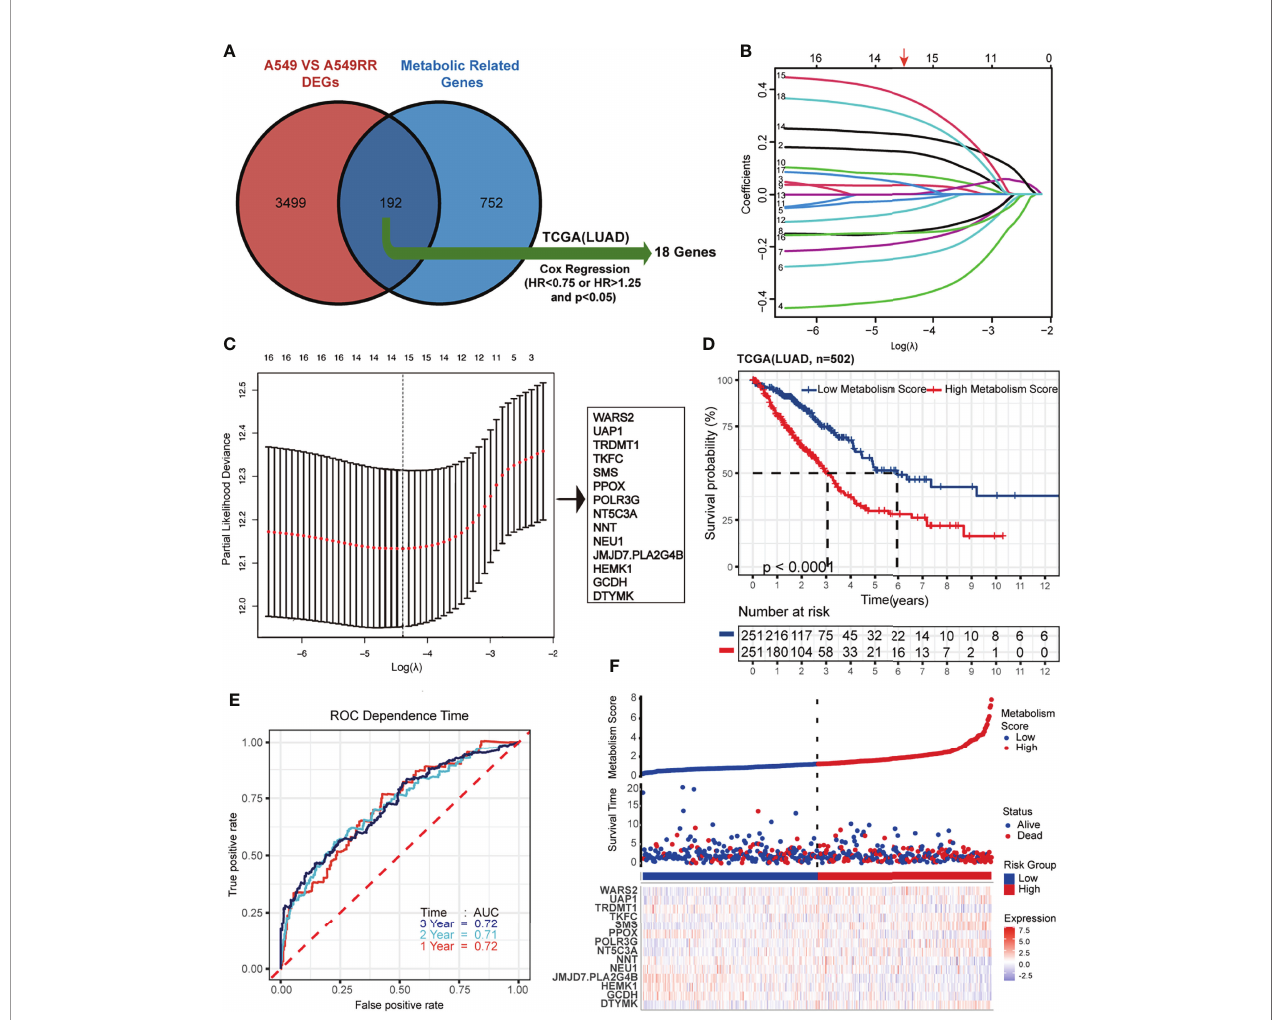
FIGURE 2 | Construction and veri fi cation of Lasso regression based on metabolic-related DEGs (MRGs). (A-C) construction process based on lasso regression. 192 common genes in DEGs and MRGs were mapped by Venn plot, and 18 genes were screened out using Cox regression based on the TCGA database (lung adenocarcinoma, LUAD). Then lasso regression complexity was controlled by lambda using the glmnet R package, and a metabolic-related prognostic model was constructed to calculate Metabolism Scores of tumors based on expression level of 14 hub genes. (D) Overall survival status of LUAD patients (N=502) with high and low Metabolism Score using Kaplan – Meier plotter analysis. (E) ROC curve based on Metabolism Score using metabolic-related prognostic model. (F) LUAD patients with survival status (middle) were ranked according to Metabolic Score (top), and expression levels genes were plotted with a heat map